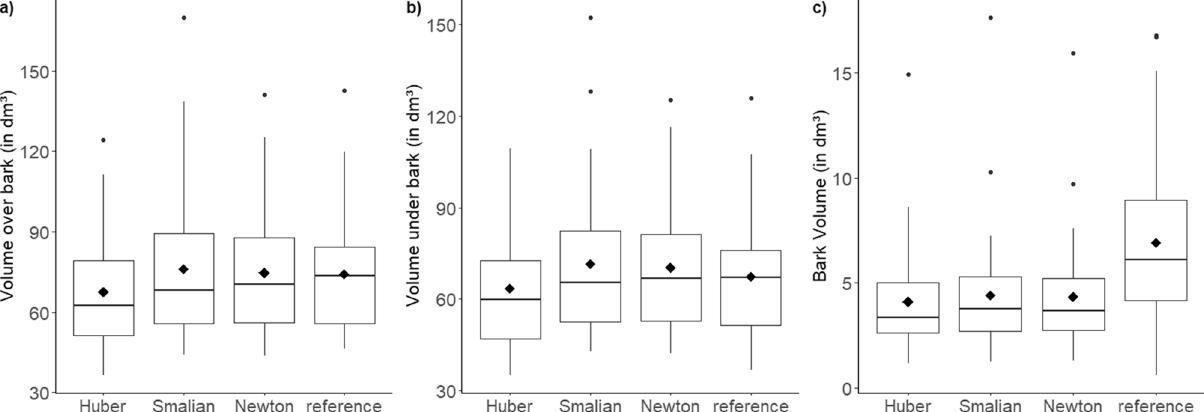
Figure 2. Boxplots of the ( a ) over bark volume, ( b ) under bark volume and ( c ) bark volume for the reference volume and volume estimated by Huber (Eq. 4), Smalian (Eq. 5) and Newton (Eq. 6) scaling formulas for spruce logs.